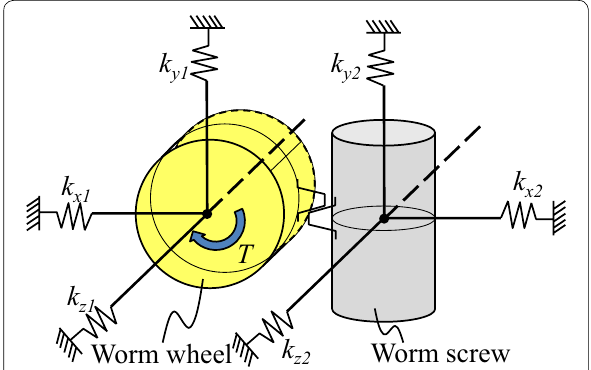
Fig. 1 Vibration model of the worm gear mechanism